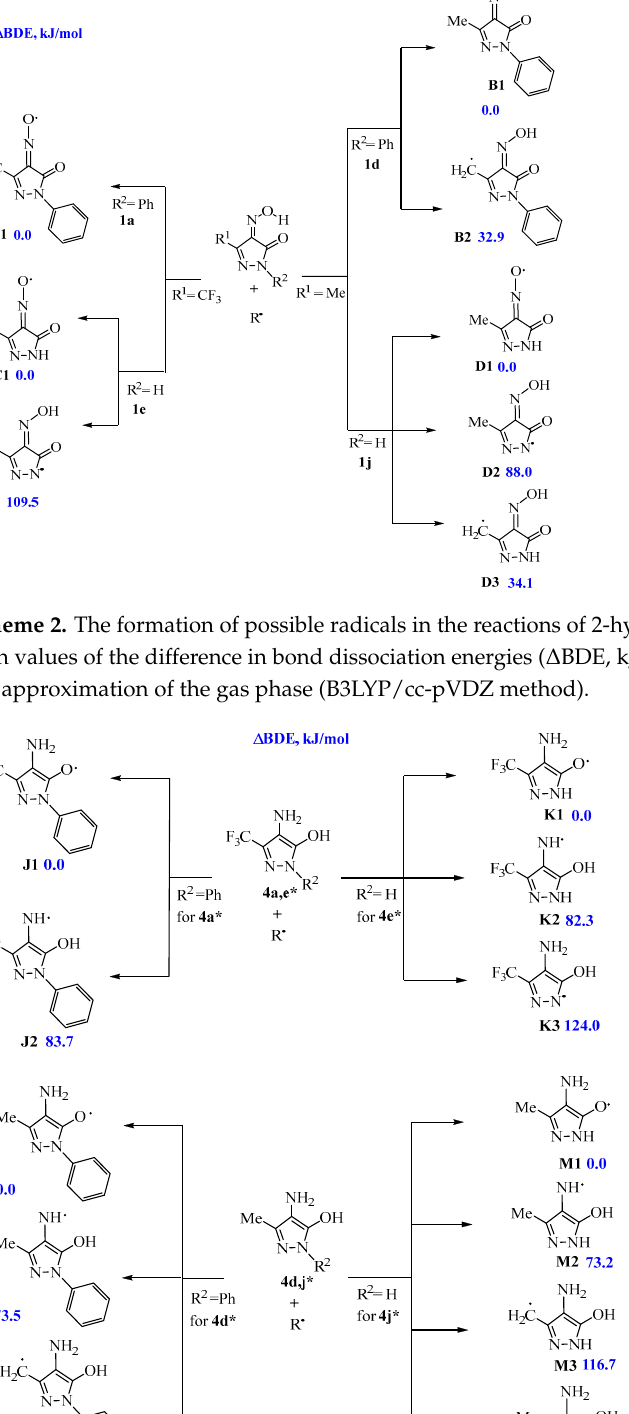
Figure 3. Antioxidant activity ( АОА , ORAC) vs. BDE functions for 4-hydroxyimino-1-phenyl- pyrazolones 1e – j ( a ) and antioxidant activity ( АОА , ORAC) vs. BDE functions for polyfluoroalkyl 4-aminopyrazolols 4a – c , 4e – i ( b ).